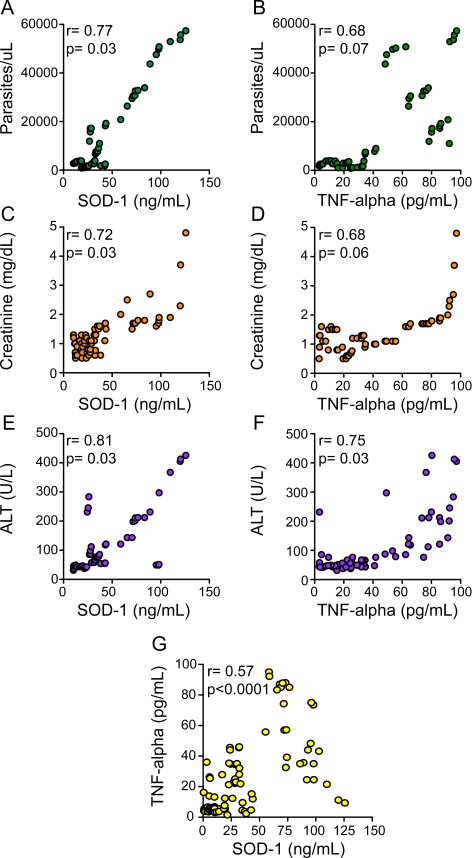
Correlations between plasma SOD-1 or TNF-alpha concentrations and laboratory parameters of malaria severity.Correlation of SOD-1 or TNF-alpha with several laboratory parameters in symptomatic vivax malaria patients (n = 69). Column at left (A, C and E): Correlations of SOD-1 with parasitaemia (A), plasma creatinine (C) and alanine amino-transaminase (ALT; E). Column at right: Correlations of TNF-alpha to parasitaemia (B), plasma creatinine (D) and ALT (F). Correlation between TNF-alpha and SOD-1 plasma protein levels is shown in G. The statistical significances were calculated using the Spearman test. The values of p and r are illustrated in each graph.